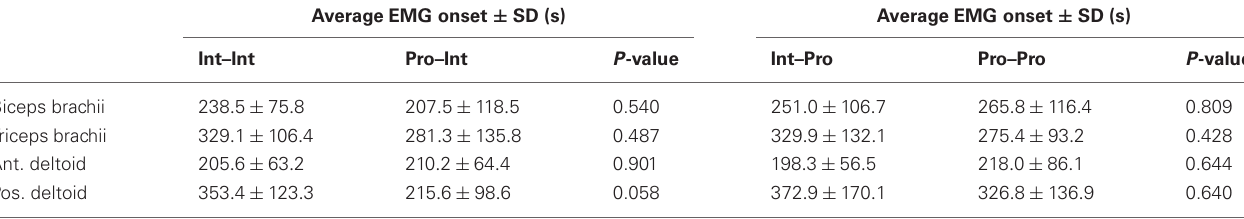
Table 2 | EMG onset